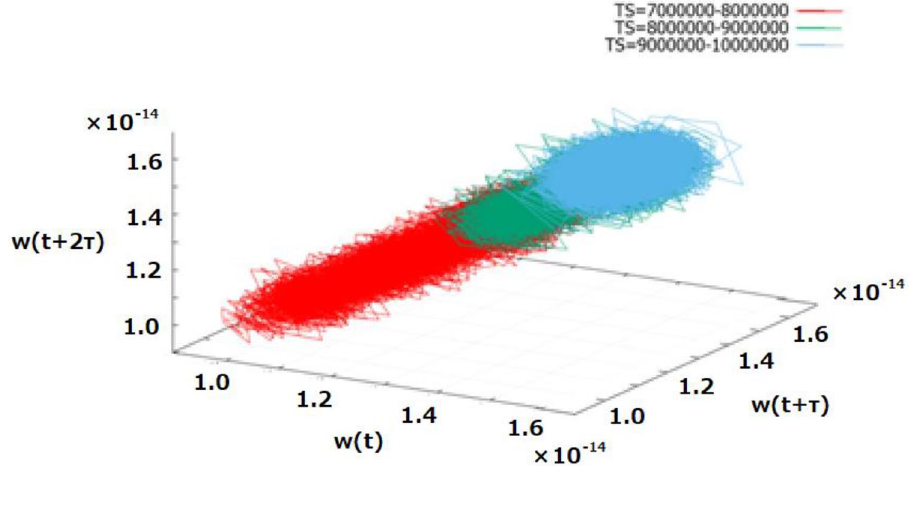
Fig. 11 Attractor of 2-vortex mode at Γ = 2.6, Re = 980 (TS = 7 million to 10 million). The numerical dimensionless values 8 on the axes indicate 9.28608 × 10